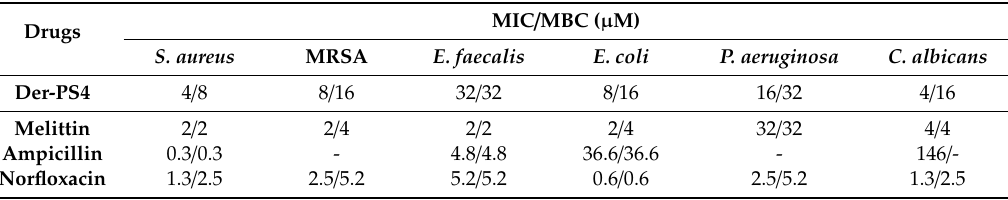
Table 2. MICs and MBCs of Der-PS4, ampicillin and